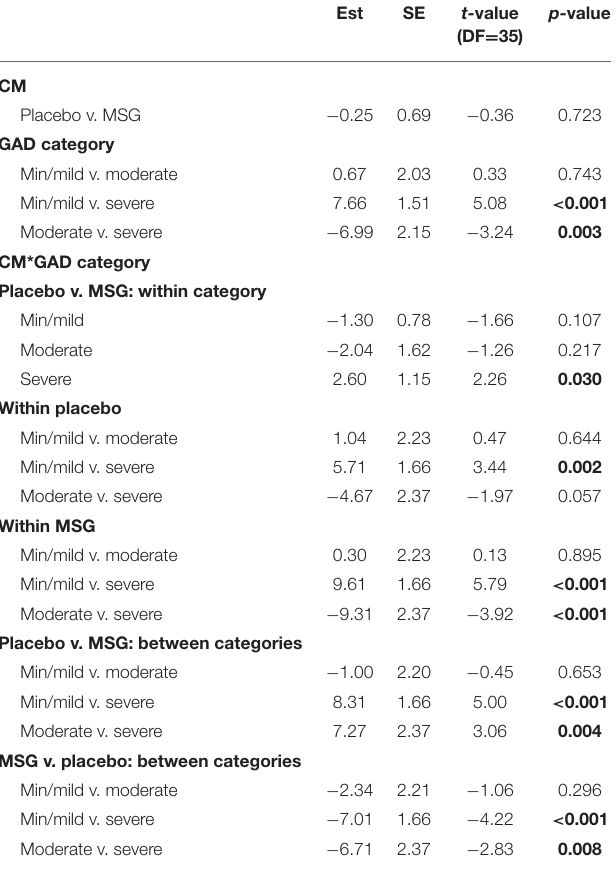
TABLE 4 | LS mean difference for treatment (MSG v. Placebo), categories, and their interaction within anxiety